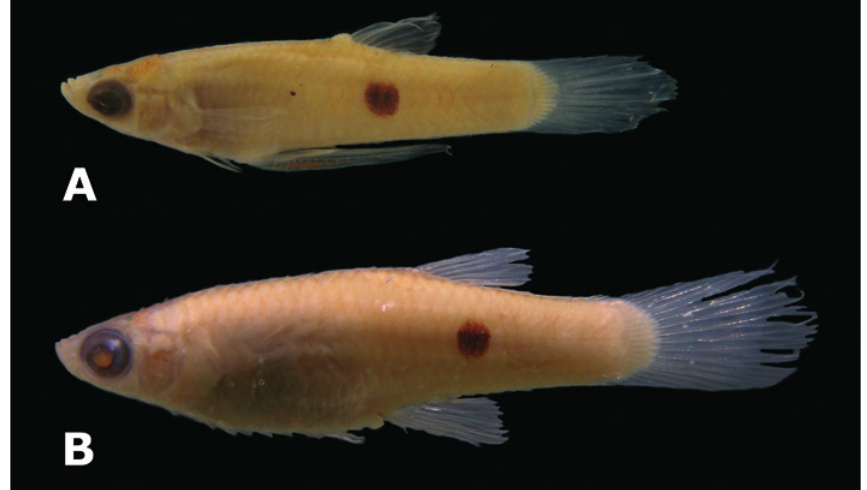
Fig. 5. Phalloceros leticiae . (A) Holotype, male, 16.2 mm SL, MCP 30551, Aruanã, rio Araguaia drainage. Goiás. Brazil; (B) paratype, female, 20.8 mm SL, MCP 30550, collected with the